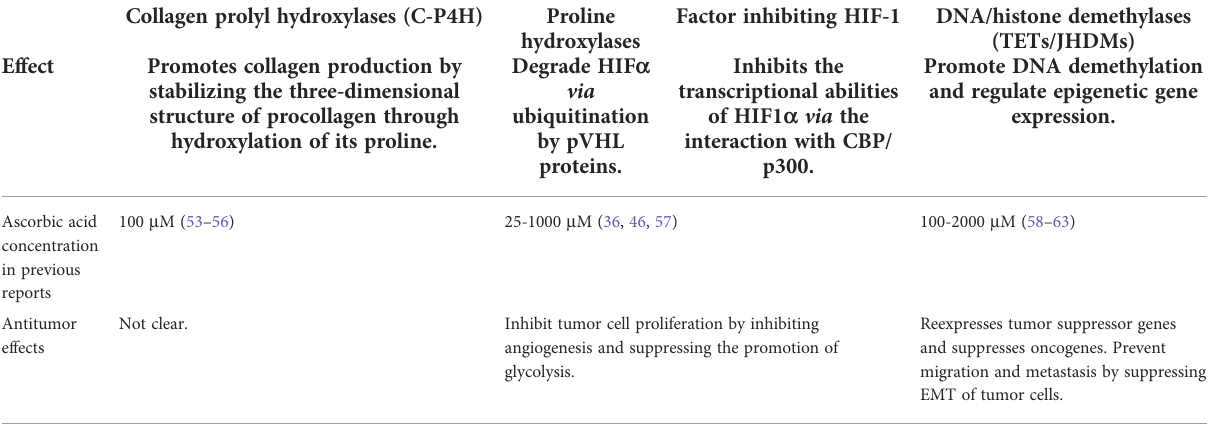
TABLE 1 The types and effects of Fe (II) and 2-oxoglutaric acid-dependent dioxygenases in which ascorbic acid acts as a cofactor. Collagen prolyl hydroxylases (C-P4H) Proline Factor inhibiting hydroxylases